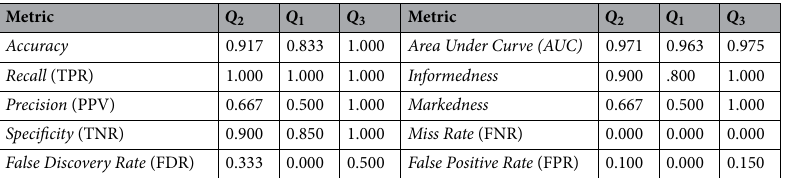
Table 4. The ensemble median ( Q 2 ), the 25% percentile ( Q 1 ), and the 75% percentile ( Q 3 ), of the distributions of the various network metrics. The statistics are derived from the Monte Carlo cross validation tests performed in Stage 3, quantifying the performance of ConcNet 2.0. The results for the five participants who were systematically misclassified have not been